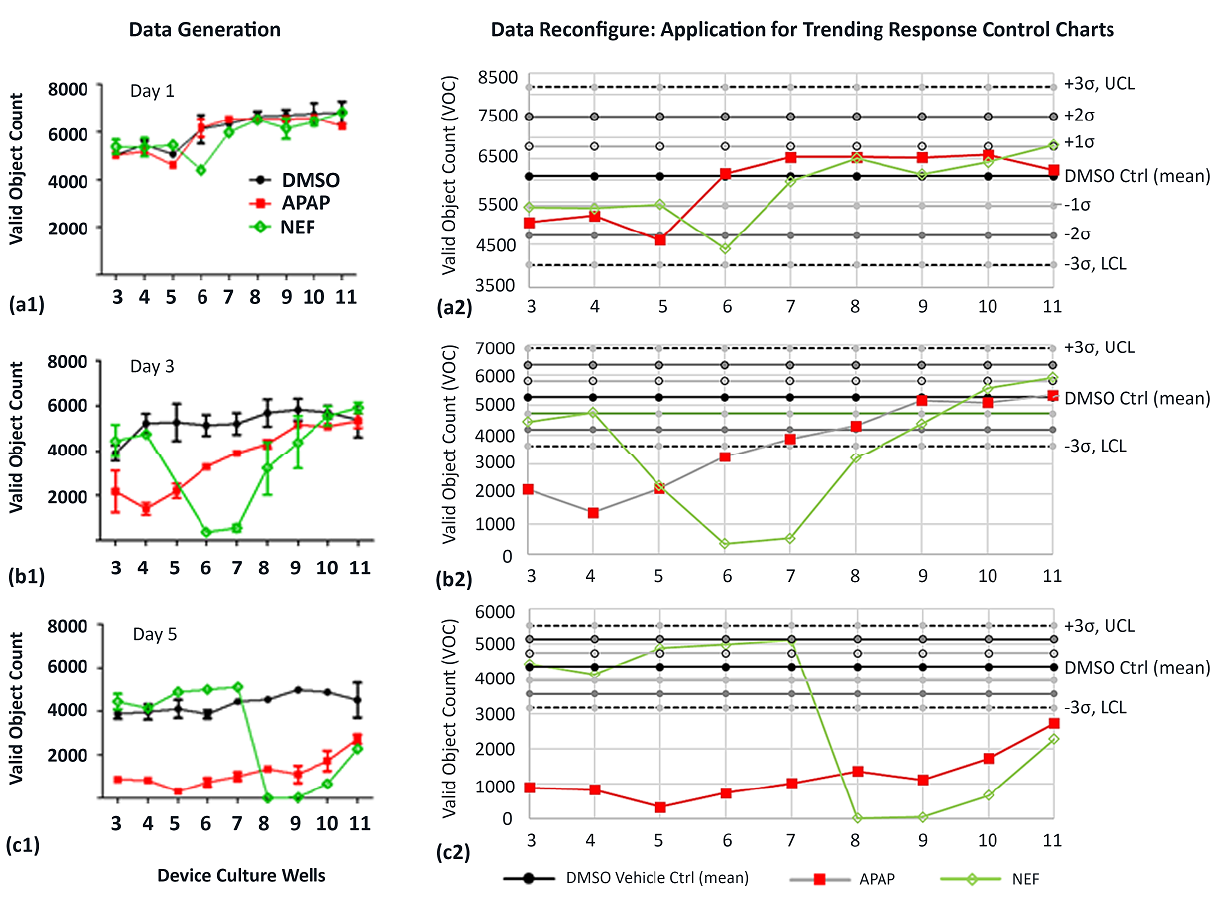
Figure 7. High content imaging to evaluate the variance of cell counts to indicate direct-compound or indirect-cell-byproduct toxicity locations; nuclei count (DAPI). Initially, HepaRGs were cultured for 7 days in static conditions prior to activating flow and dosing 1× daily (well 1). ( a1 , a2 ) After 1 day and a single bolus dose in well 1. The DMSO control is baseline culture while APAP and NEF are study compounds. ( b1 , b2 ) After 3 days and three bolus doses into well 1. ( c1 , c2 ) After 5 days and five bolus doses into well 1. Data are expressed as means ± SEM (n = 9). Applied statistics ( a2 , b2 , c2 ) using six-sigma control charts with DMSO vehicle control signifying process average (mean) and ±1 σ (68%), ±2 σ (95%), and ±3 σ (99.73%) significance offsets. If data fall outside of significant offsets, UCL or LCL, variations in the data imply special or assignable causes, ( b2 , c2 ).